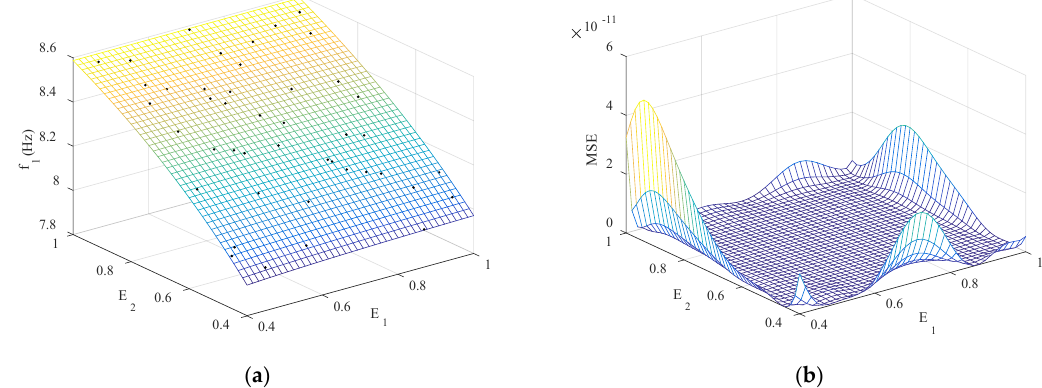
Figure 12. The first frequency in the function of E 1 and E 4 : ( a ) Kriging model and data samples; ( b ) the